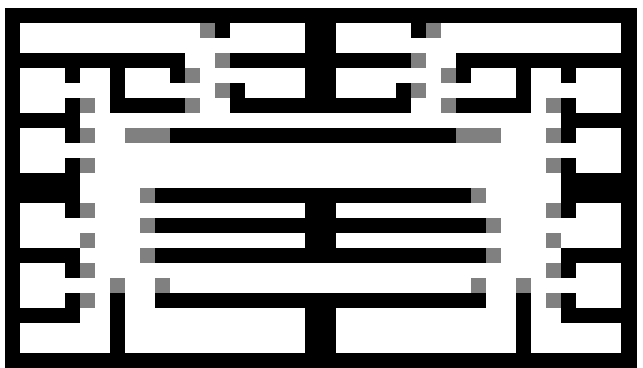
Fig. 15. Lab map input as image